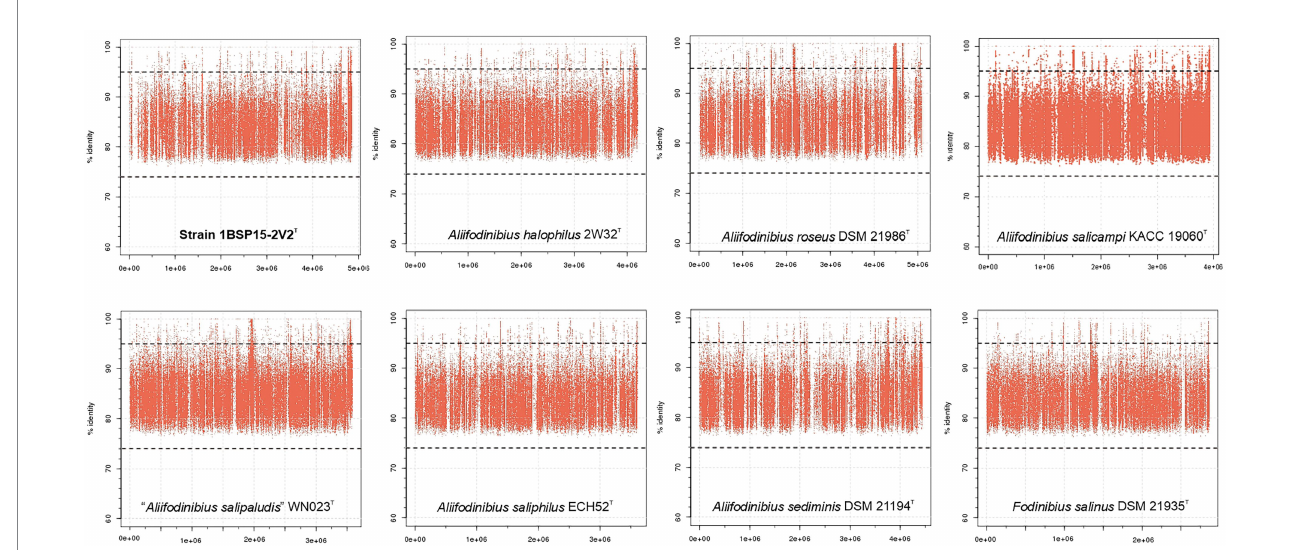
FIGURE 10 Genomic recruitment plots for the isolated strain 1BSP15-2V2 T and other type strains of species of the genera Aliifodinibius and Fodinibius against SMO1 hypersaline soil metagenomic reads. X-axis represents the genome length and Y-axis represents the percentage of identity of the reads matching the genome. Red dots above the 95% threshold line indicate read assignment at the species level. As it can be seen, most of the reads matches the genome at 80%–90% identity (above the proposed 73.98% for genus delineation), meaning they cannot be affiliated to any of the described Aliifodinibius / Fodinibius species, but they probably belong to a closed relative well represented in the SMO1 hypersaline soil.